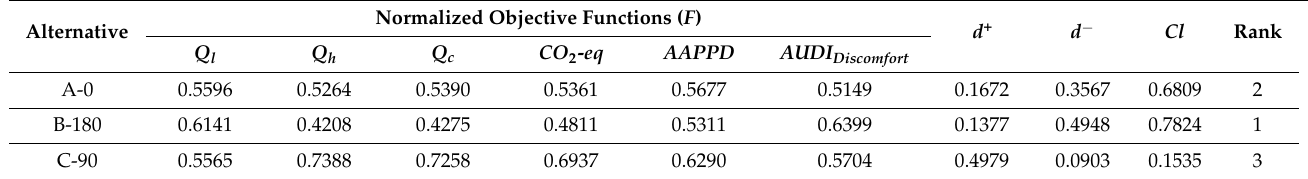
Table 7. The TOPSIS results for the optimal orientations of the three different building types, including, types A, B, and C.